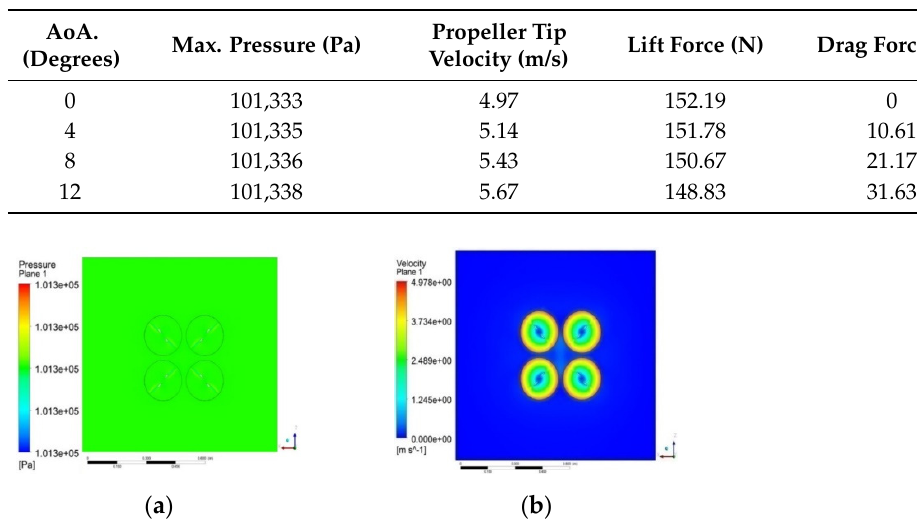
Table 13. Lift and drag force for different AoA during hovering phase.